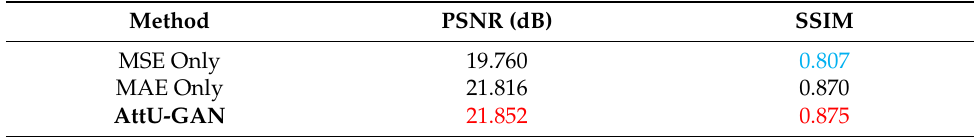
Figure 6. Subjective comparisons on real ‐ world underwater images. From left to right are raw underwater images, the results of using MAE loss function only and using our proposed loss function. Table 4. Full ‐ reference image quality evaluation.